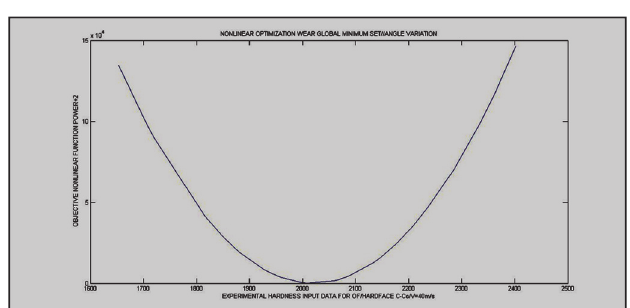
Fig. 8. Objective function (OF) nonlinear optimization results for Table VI and Eq. (3) model, Matlab 2009-12. The impact velocity is 40 m/s. Results are acceptable with a Global Minimum sharply determined and running time is lower than a second.